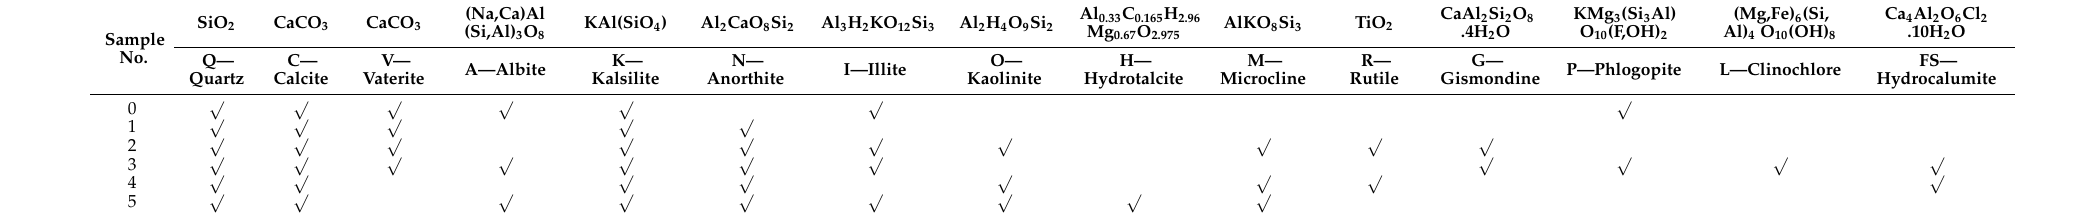
Table 9. The crystalline phases in concrete specimens of the